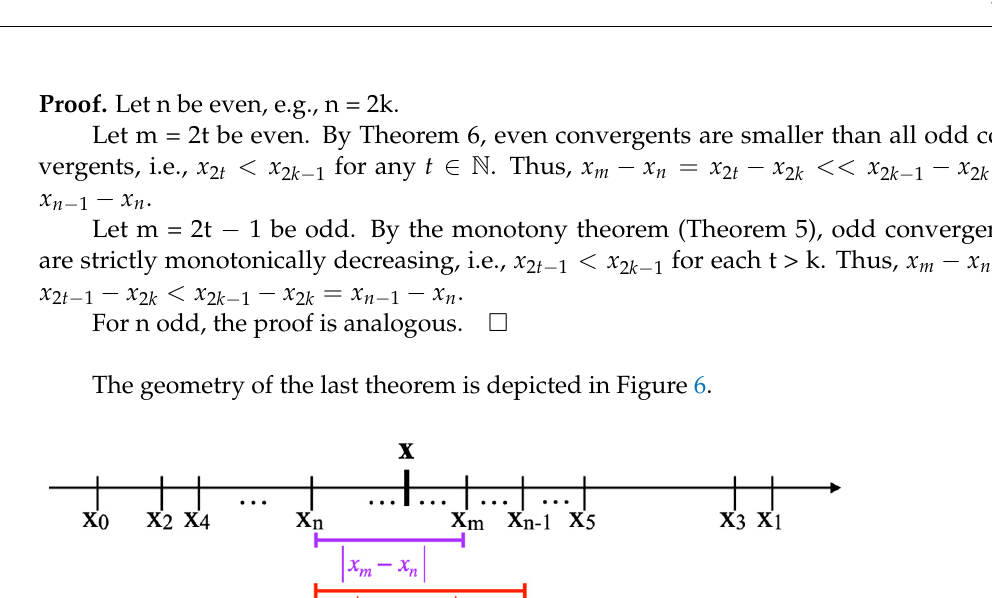
10 Figure 5. The distance between two succeeding convergents is greater than the distance of a conver- gent and the value of its continued fraction. Similarly, the difference between any two arbitrary convergents can be estimated by the difference of the convergent with the smaller index and its immediate predecessor: Theorem 9 . (Difference Theorem)